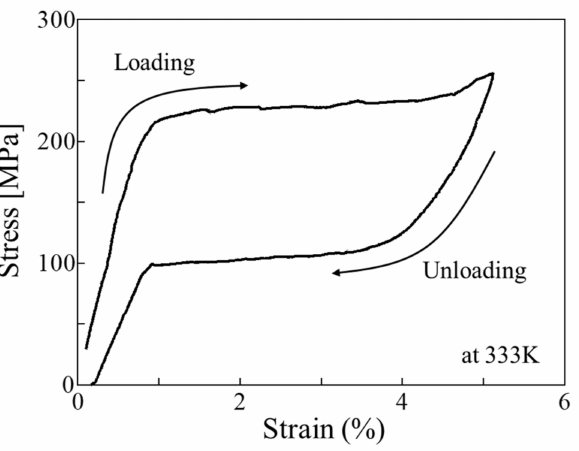
Figure 4. The stress–strain curve of a heat-treated Ti-Ni SMA element with flat tape shape at 333